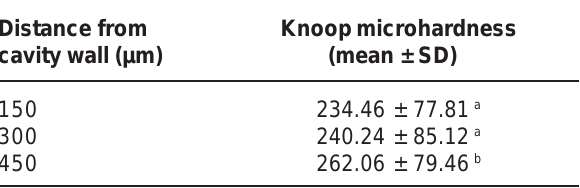
Different letters indicate significant differences among groups